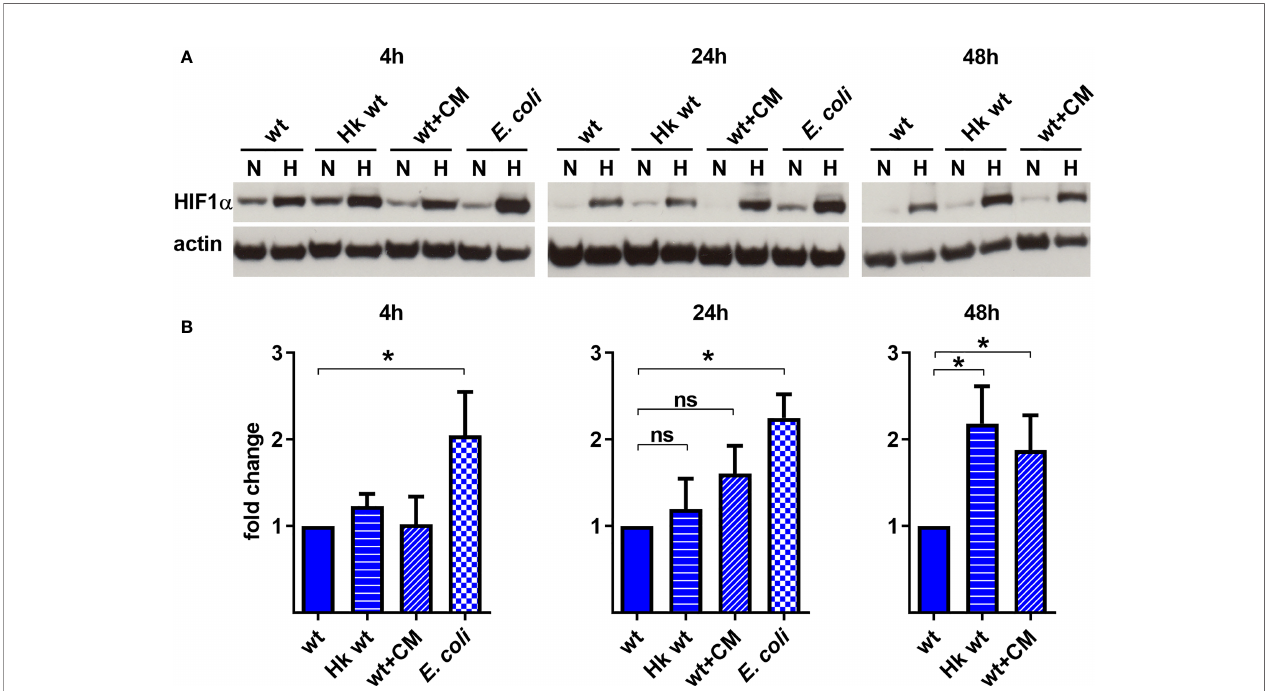
FIGURE 3 | C. burnetii -mediated reduction of infection-induced HIF1 a depends on bacterial viability. (A, B) Murine BMDM infected with C. burnetii (wt), heat-killed C. burnetii (Hk), chloramphenicol-treated C. burnetii (CM, 25 µg/ml) or E. coli for 4, 24 and 48 h under normoxia (N) or hypoxia (H) were analyzed by immunoblot using antibodies against HIF1 a and actin as loading control. Importantly, E. coli infected BMDMs were only cultivated for 24 h under hypoxia, as cell viability was signi fi cantly reduced at later time points. (A) One representative immunoblot from 4 independent experiments is shown. (B) Densitometric analysis of the HIF1 a /actin ratio was performed using ImageJ. Fold changes under hypoxia (H) are shown relative to cells infected with viable bacteria. Mean ± SD, n=4, one-sample t-test. *p < 0.05, ns=p >